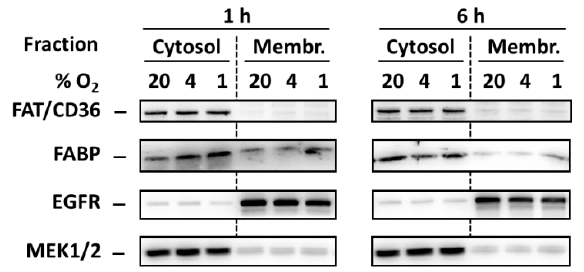
Figure 5. E ff ect of hypoxia (see “Materials and Methods”) on the level of FAT / CD36 and FABP 1 and 6 h after the treatment in cytosolic and membrane-enriched fraction of NES2Y cells. Levels of the tested proteins were determined using western blot analysis employing relevant antibodies (see “Materials and Methods”). Equal protein load was checked after blotting by staining with Ponceau S solution. The level of EGFR (membrane protein) and MEK1 / 2 (cytosolic protein) were used to confirm that the preparation of fractions was successful. The data shown were obtained in one representative experiment from at least three independent experiments .